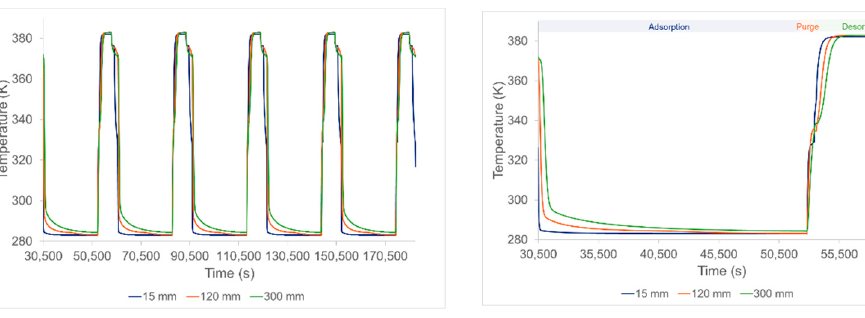
Figure 3. Temperature profiles of successive cycles ( left ) and a zoom on a single cycle ( right